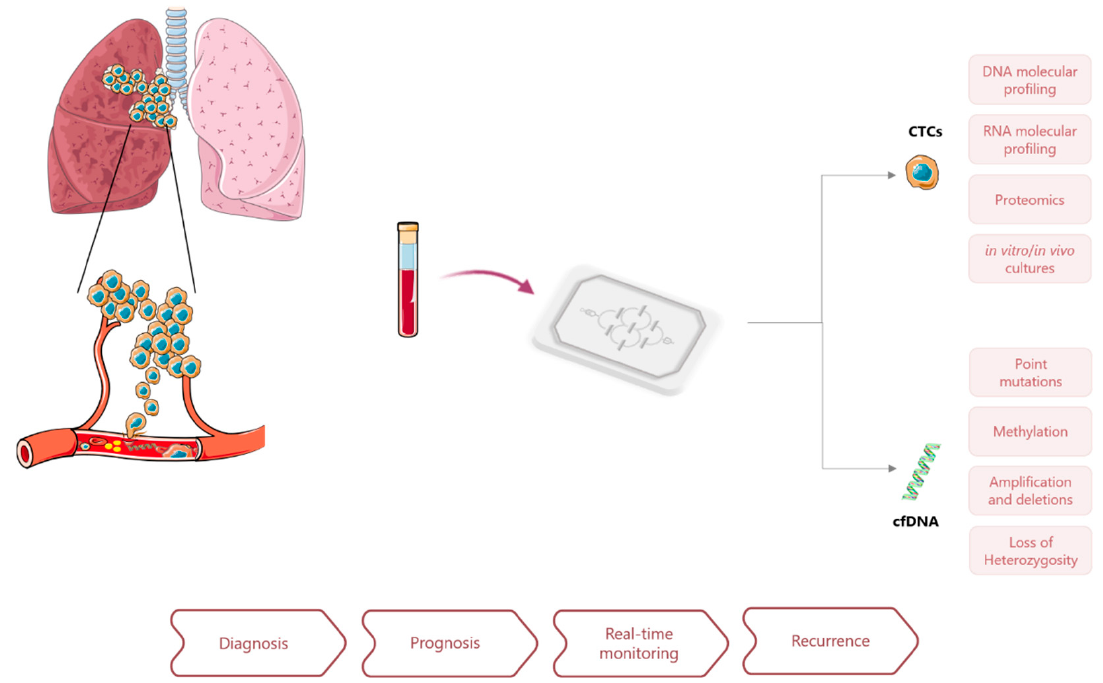
Figure 1. Application of microfluidics approaches for liquid biopsy in lung cancer and potential clinical applications of CTCs and ctDNA analysis for cancer diagnosis and management.